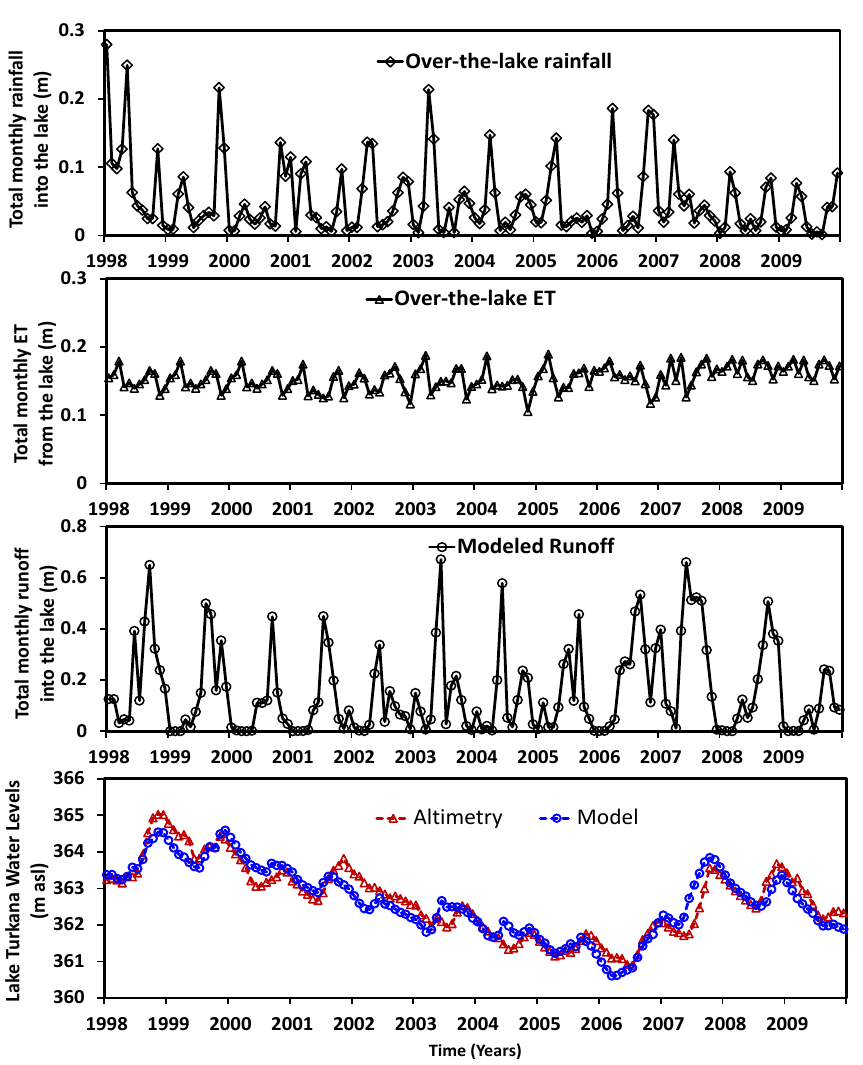
Fig. 7. (a) Total average basin rainfall (mmonth − 1 ) modelled using satellite rainfall estimates; (b) total over-the-lake ET o (mmonth − 1 ) estimated from GDAS ET o ; (c) total average basin runoff (mmonth − 1 ) modelled for the Lake Turkana basin; (d) Lake Turkana water levels for 1998–2009. Modelled daily lake levels (in blue) and lake level estimates from TOPEX/Poseidon (T/P), Jason-1, and ENVISAT satellite altimetry data (in dark